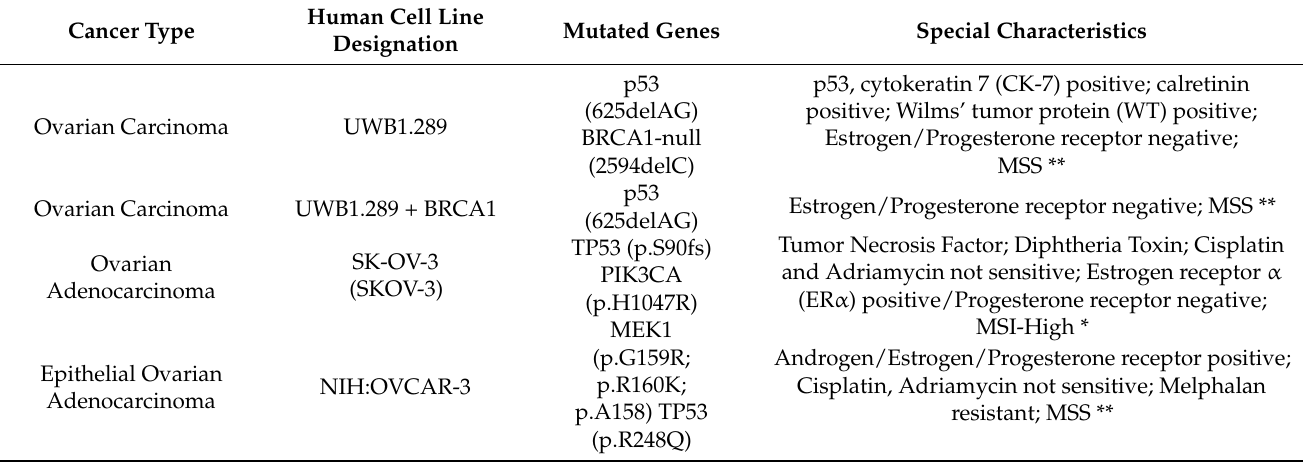
Table 1. Human ovarian cancer cell lines tested for the in vitro analysis of the compounds’ biological activity. Cancer